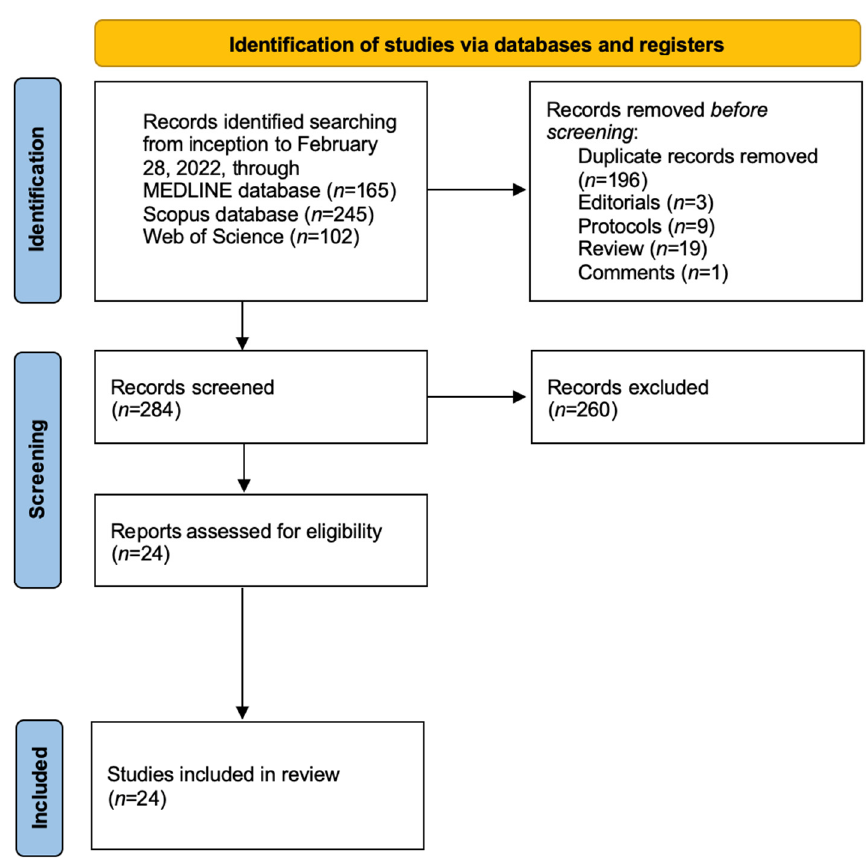
Figure 2. Flow diagram of the Systematic Review.